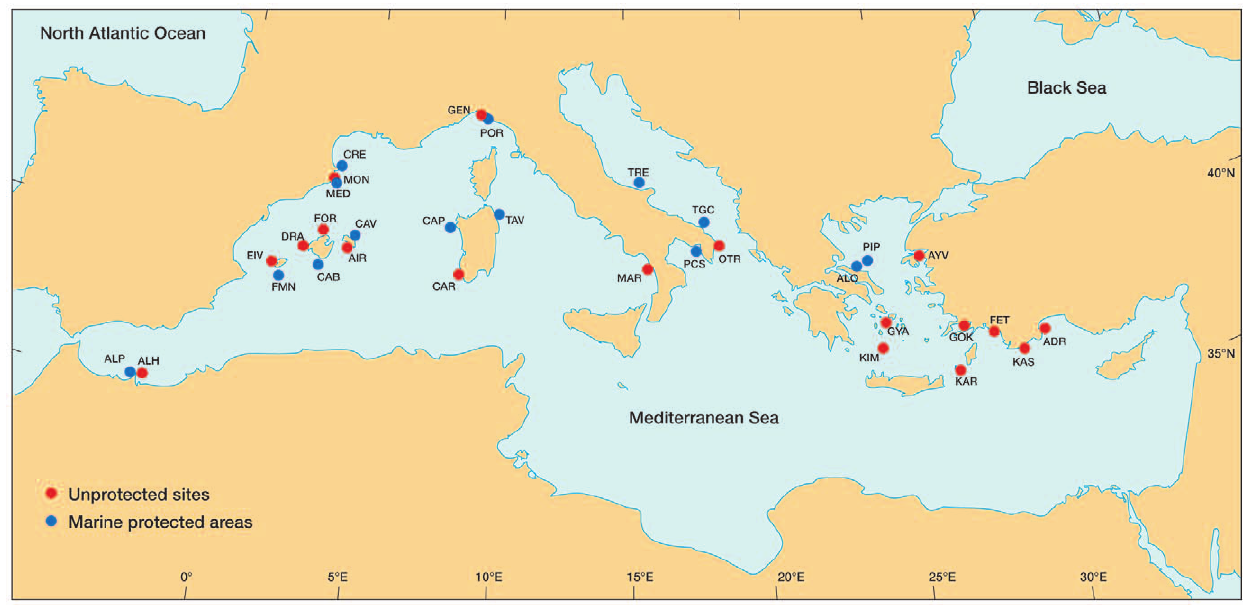
Figure 1. Map of study locations. ADR=Adrasan, AIR=Illa de l’Aire, ALH=Al-Hoceima (unprotected), ALO=Alonissos, ALP=Al-Hoceima MPA, AYV=Ayvalik, CAB=Cabrera, CAP=Capo Caccia, CAR=Carloforte, CAV=Cap de Cavalleria, CRE=Cap de Creus, DRA=Dragonera, EIV=Eivissa, FET=Fethiye, FMN=Formentera-Espardell, FOR=Cap Formentor, GEN=Genoa, GOK=Go¨kova, GYA=Gyaros, KAR=Karpathos, KAS=Kas, KIM=Kimolos-Polyaigos, MAR=Maratea, MED=Medes Islands, MON=Montgrı´, OTR=Otranto, PCS=Porto Cesareo, PIP=Piperi, POR=Portofino, TAV=Tavolara, TGC=Torre Guaceto, TRE=Tremiti. For details on protection level see Figs. 2–3 and Table 1.